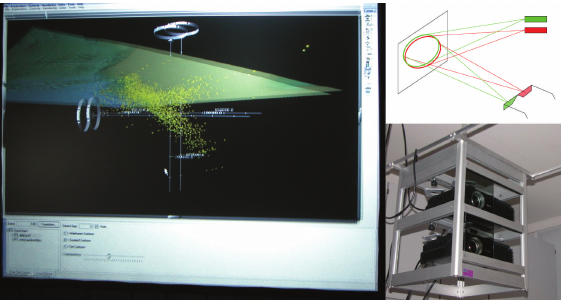
Figure 3: The low-cost 3D stereoscopic projection equipment of our working group. Two data projectors (right side of the figure) deliver two perspective views, passing perpendicular aligned polarization filters. A reflective-coated screen (left side) preserves the polarization state of each picture due to metallic reflection. Viewing through polarizing glasses, each eye just sees its distinct perspective view, and a stereoscopic depth impression is the result. Compare the simple sketch in the right upper corner, as it demonstrates the technical principle of such a Geowall setup